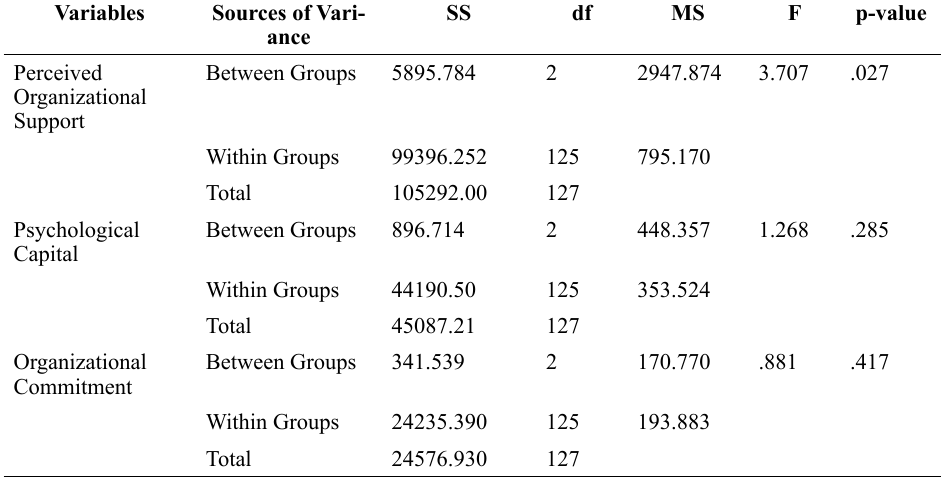
Analysis of Variance (one way) showing the Mean Differences of Perceived Organizational Support, Psychological Capital, and Organizational Commitment with respect to Job